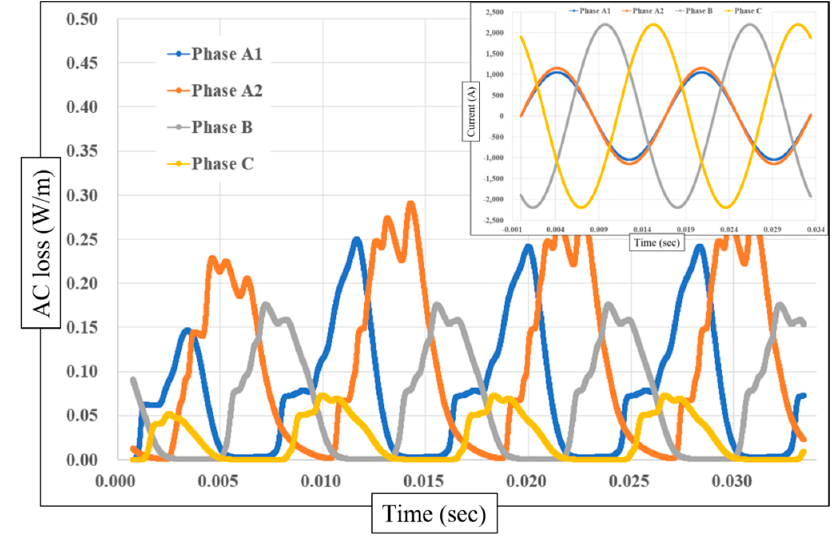
Figure 5. AC loss of the FEM model for loss analysis (at 2200 A peak ).